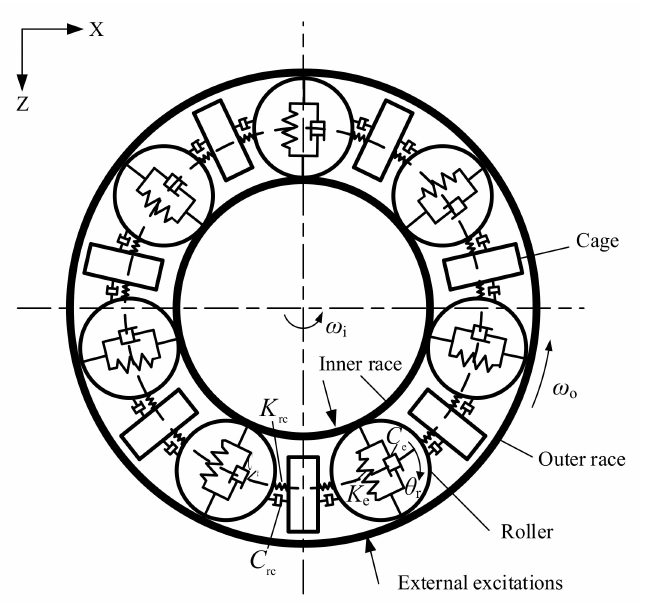
Figure 2. Schematic of the rolling